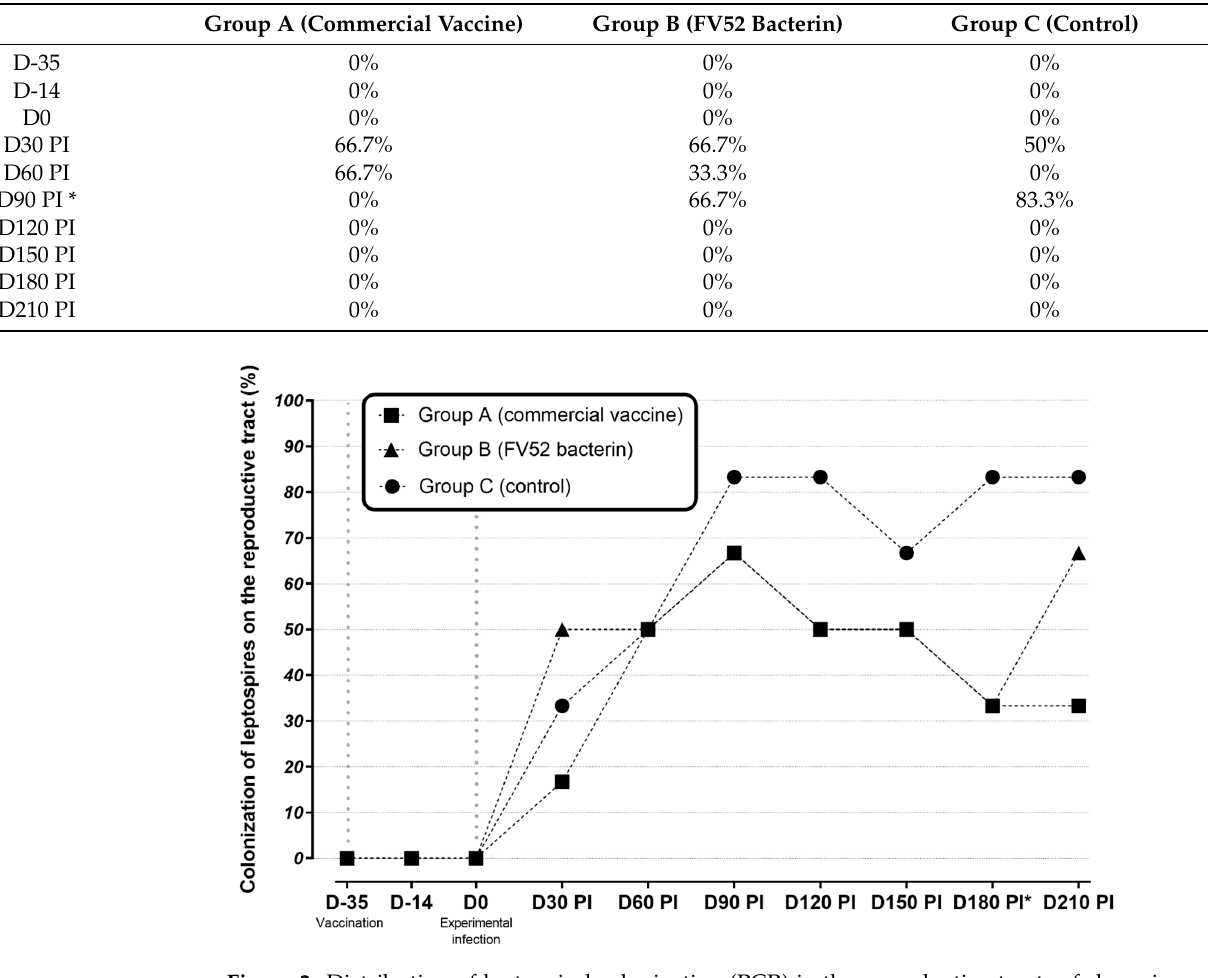
Figure 2. Distribution of leptospiral colonization (PCR) in the reproductive tracts of sheep in unvaccinated (control), vaccinated groups between D-35 (first vaccine dose) and D210 post-infection. * p < 0.05 between vaccinated and non-vaccinated groups.